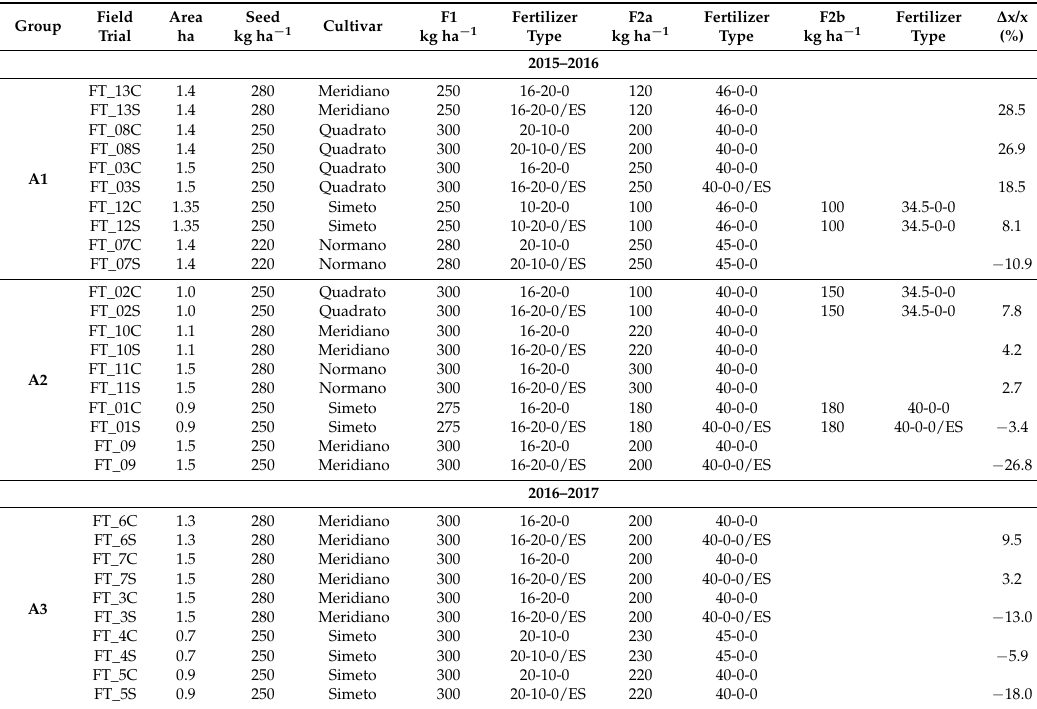
Table 1. Fertilization schemes per trial. FT, field trial; C, field trial with the conventional fertilization (F-)treatment, S, the corresponding field trial with incorporated elemental sulfur in the fertilization scheme (FBES-treatment); F1, initial fertilization along with sowing; F2a, first additional fertilization; F2b, second additional fertilization; ∆ x/x, percentage relative change of grain yield; 46-0-0, urea; 40-0-0, urea plus ammonium sulfate; 34.5-0-0, ammonium nitrate; /ES, fertilizer granules with incorporated 2% elemental